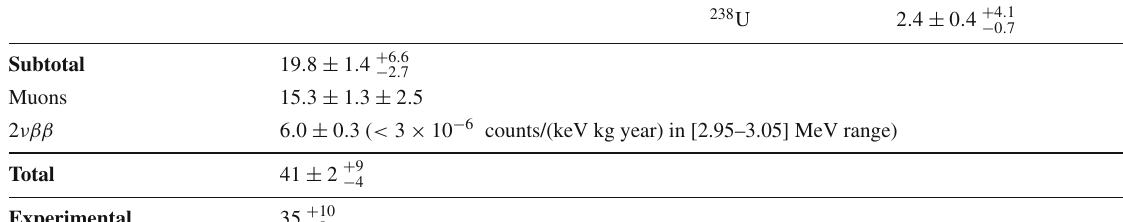
ducing background in the ROI bkg , i.e 228 Ra– 208 Pb and 226 Ra– 210 Pb, respectively. The counting rate quoted for Reflectors includes also the contribution from surface contaminations of the Holder . The 232 Th source limit (90% CL) corresponds to the maximum one obtained from the analysis of systematic uncertainties. The contribution from 2 νββ is produced exclusively by events with energy < 2950